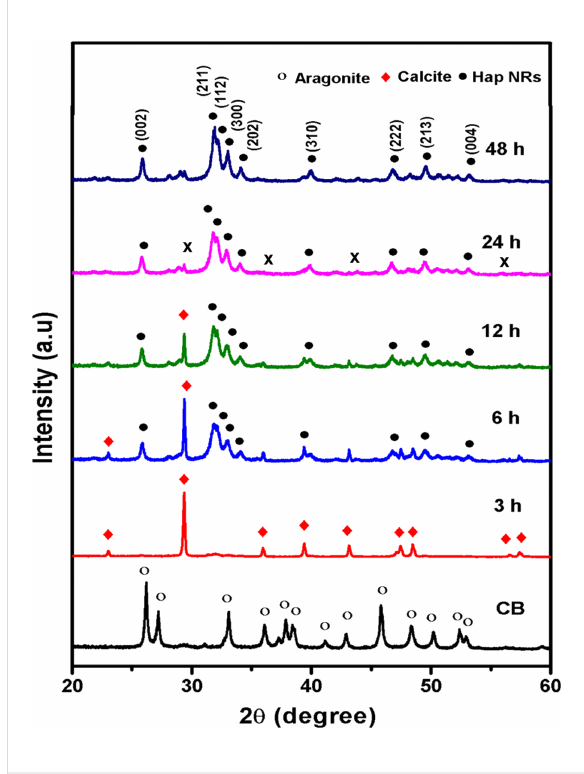
Figure 1: XRD spectrum of aragonite cuttlefish bone (CB), calcite, and hydroxyapatite (Hap) nanorods using cuttlefish bone powder as a pre- cursor (CB-Hap NRs). The impurity peaks are indicated by an